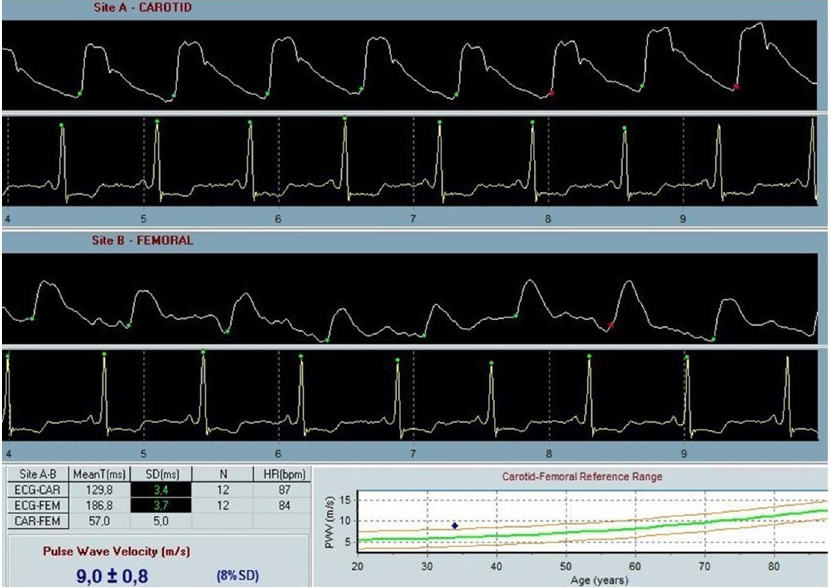
Figure 1. PWV analysis from a study participant with high for age PWV, i.e. PWV above the age-adjusted normative values based on healthy population